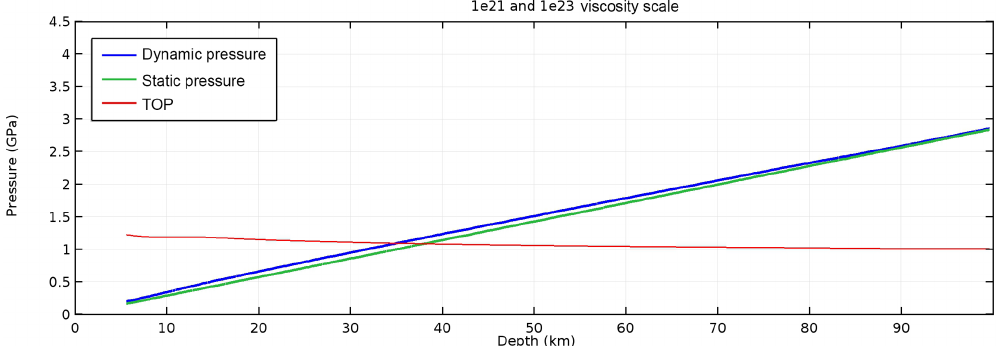
Figure 9. Calculated plots of pressure as a function of depth along the channel axis. Note that when we assign an outlet pressure (calculated lithostatic pressure at the depth of the bottom wall) to the bottom wall, TOP does not develop in most of the